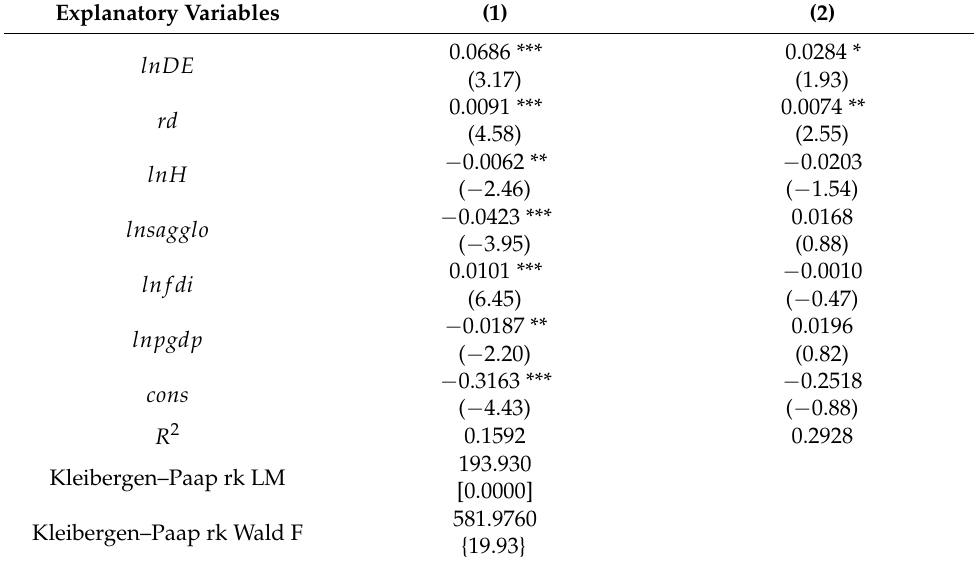
Table 5. Robustness test